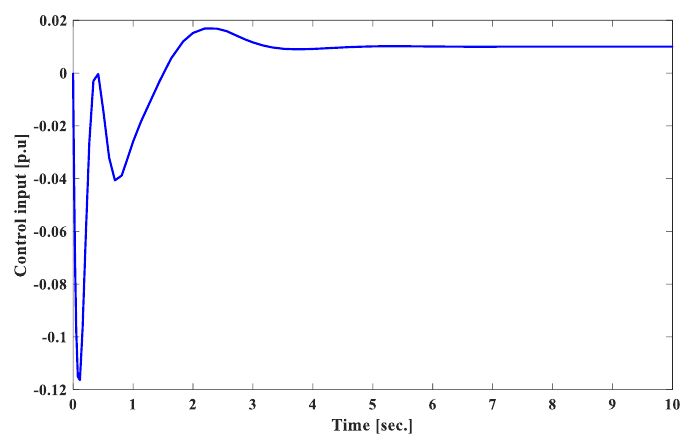
Figure 21. Control input [p.u.] of the first control area under matched disturbances.